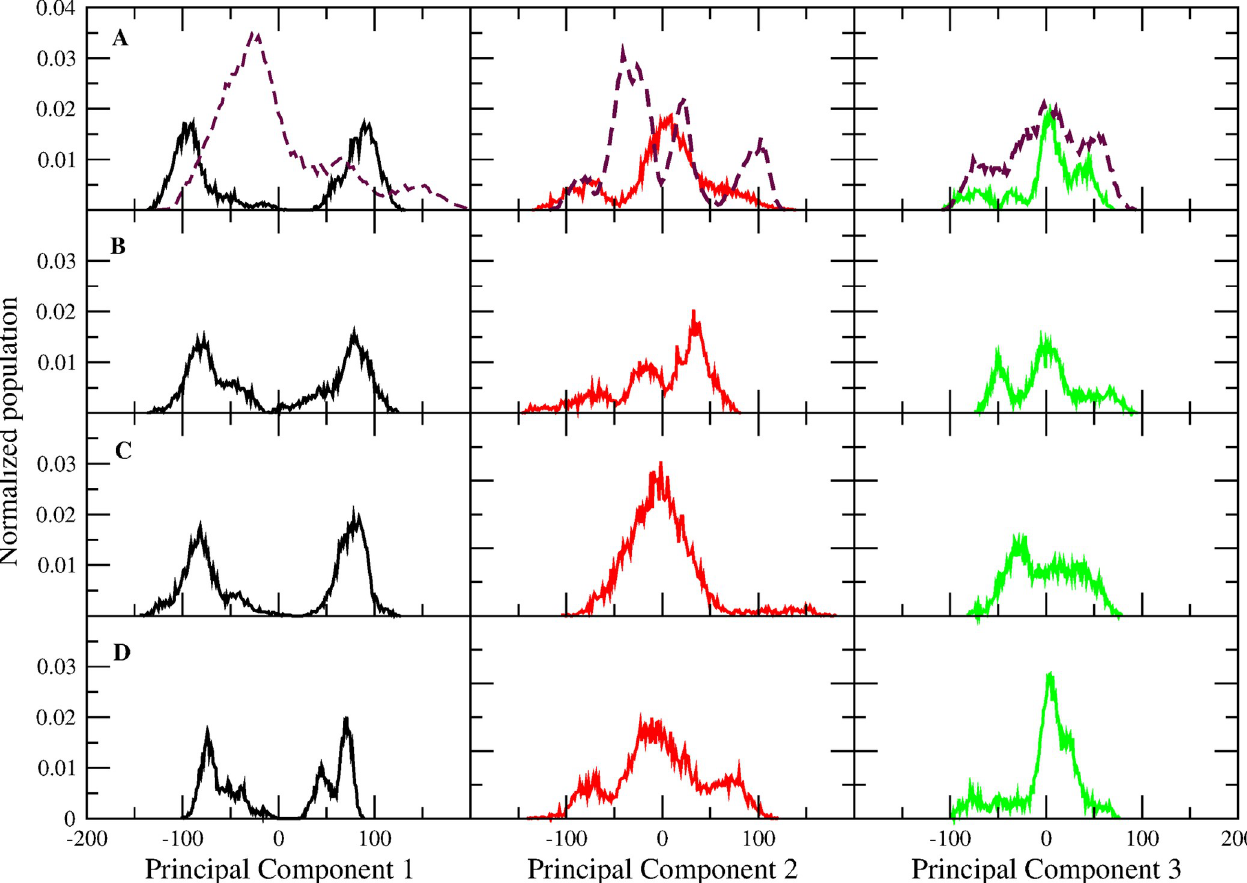
Fig 2. PCA distribution of RdRP conformers. Normalized population of conformers along principal component 1 (black), 2 (red), and 3 (green) for (A) RdRP-SWE, (B) RdRP-AMR, (C) RdRP-SIT, and (D) RdRP-COR systems. The dotted line in sub figure A is for the RdRP-APO system.